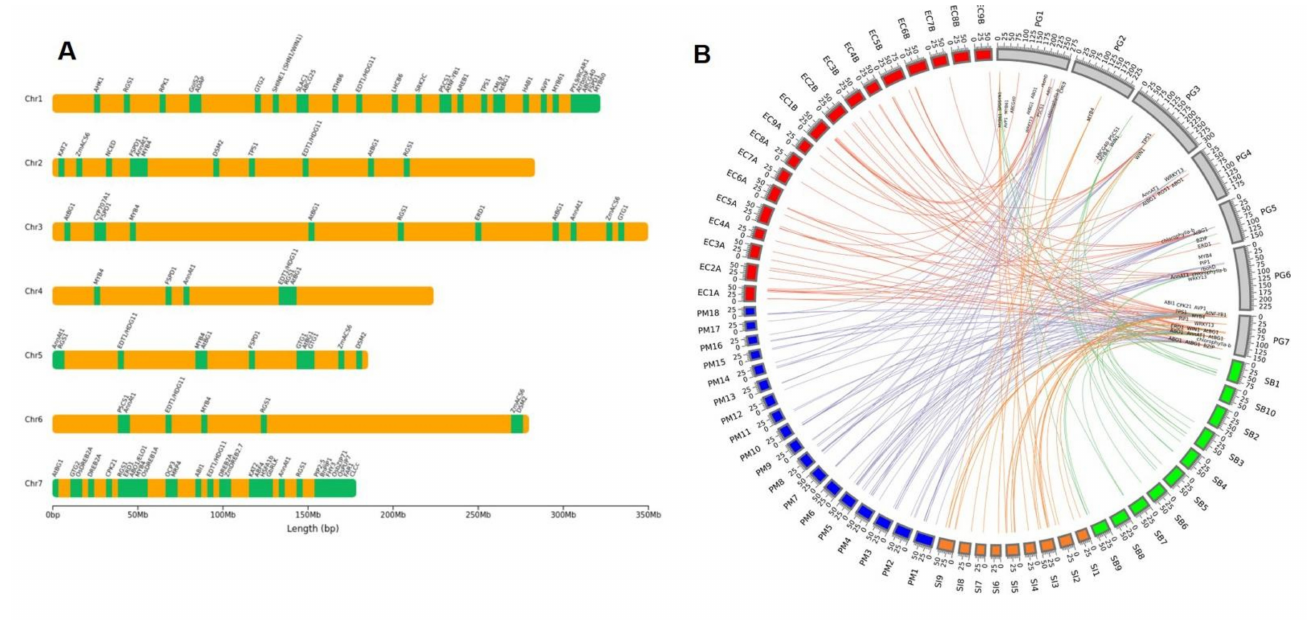
Figure 1. ( A ) Chromosomal distribution of 74 genes associated with drought in pearl millet. ( B ) Circos plot representing chromosomal positions of orthologous drought genes in different millet